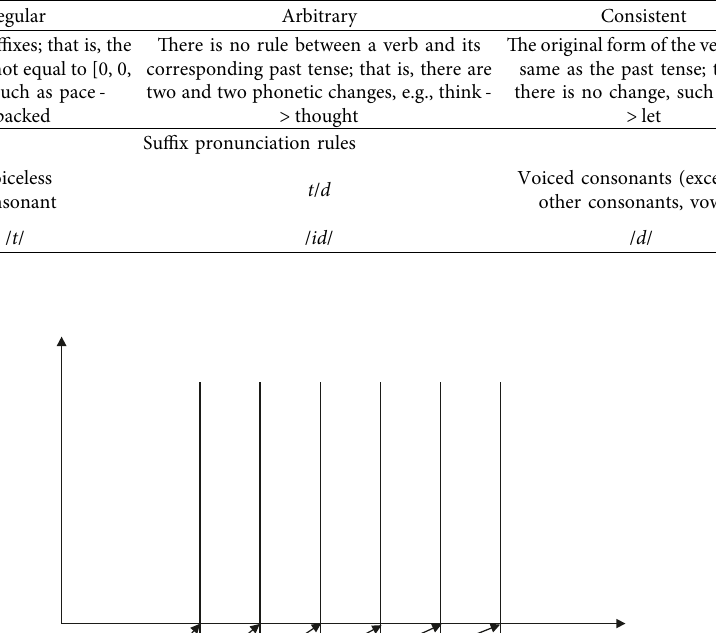
Table 2: Construction rules of past tense of verbs.